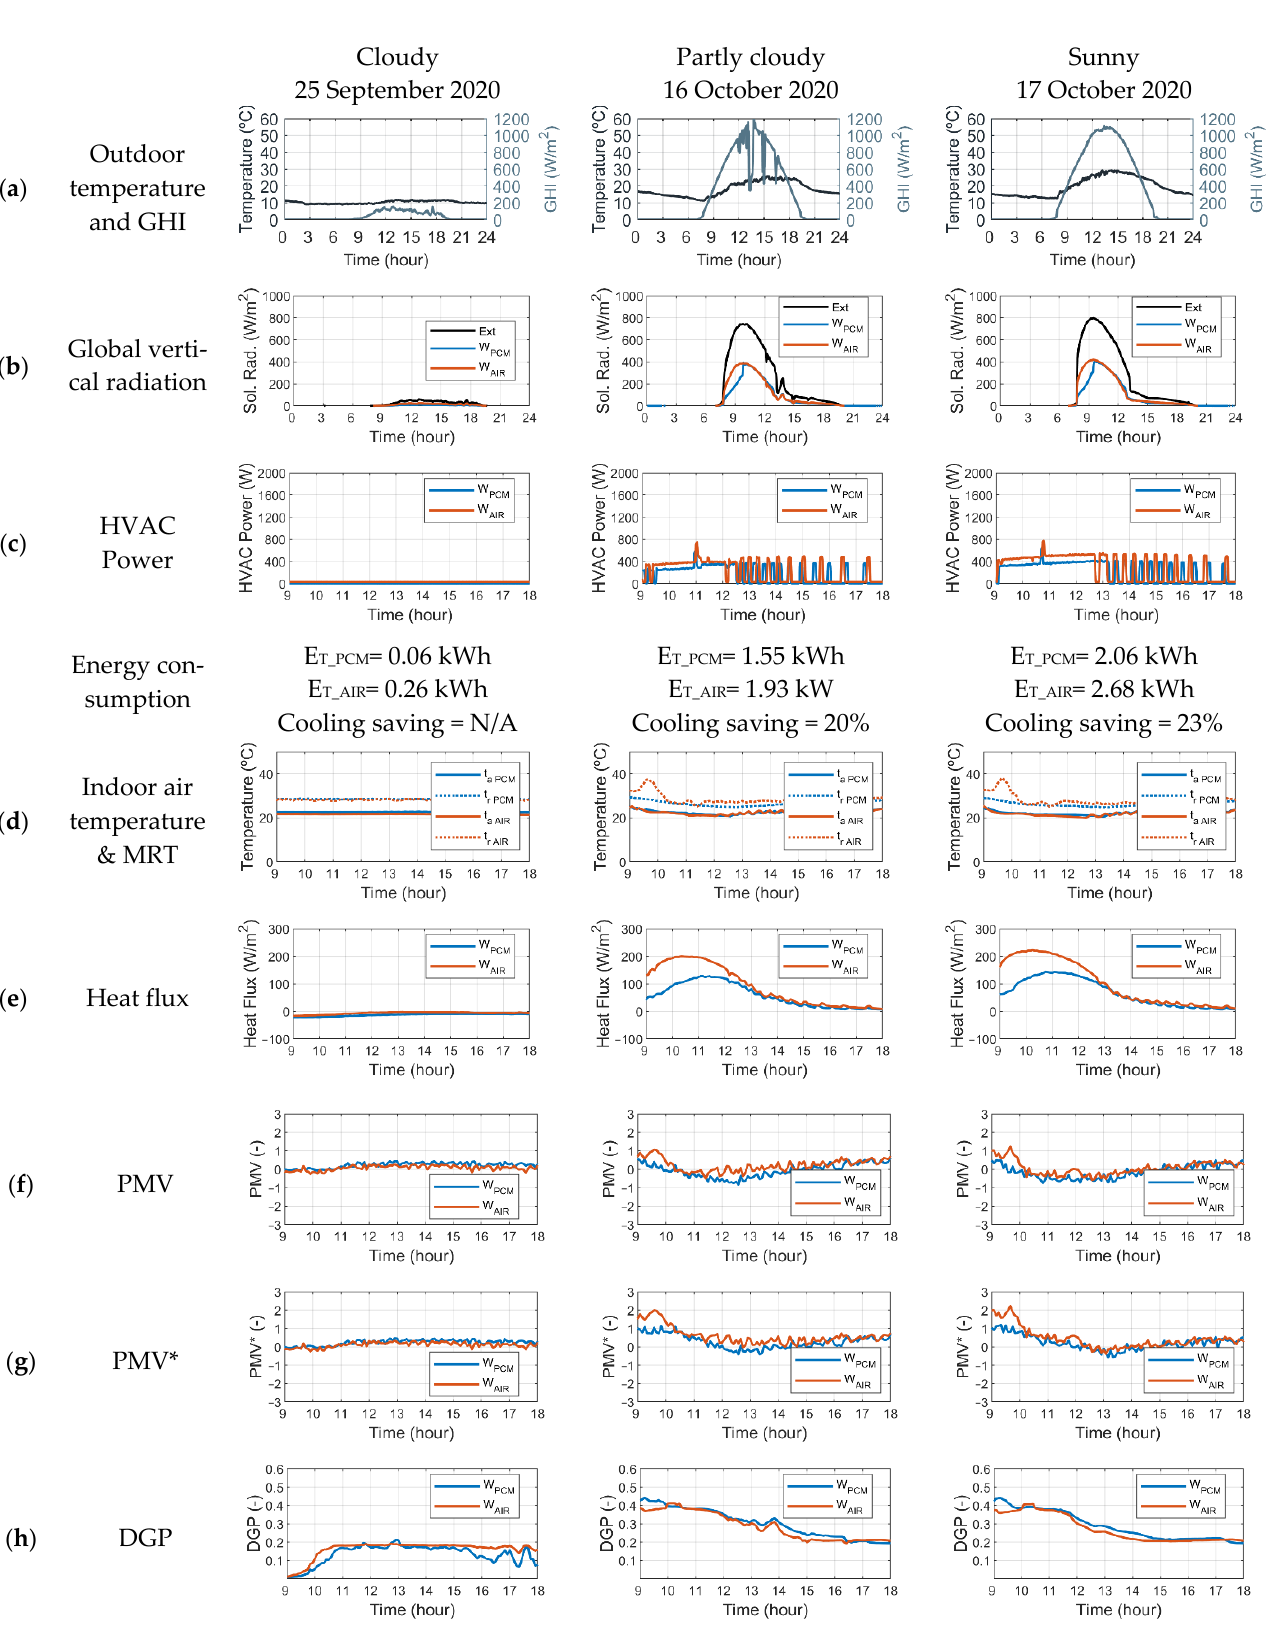
Figure 9. Results for representative days of summer. ( a ) Outdoor temperature and global horizontal radiation (GHI); ( b ) global vertical radiation; ( c ) HVAC power and energy consumption; ( d ) indoor air temperature & mean radiant temperature (MRT); ( e ) heat flux; ( f ) PMV; ( g ) PMV*; ( h ) DGP.